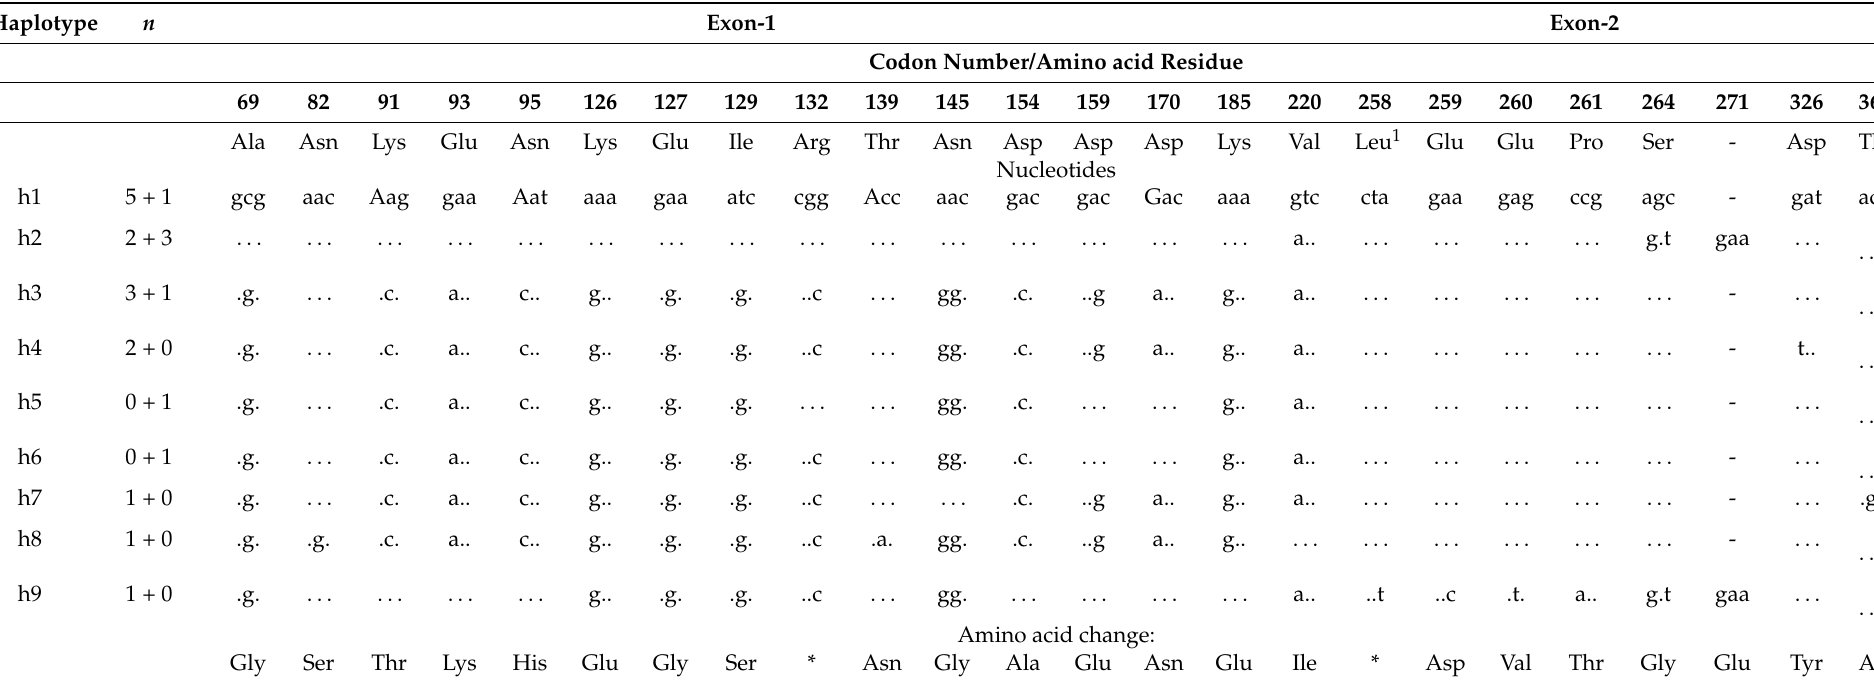
All seven sequences obtained in this study had codons ctc ttc tcc ttc at the amino end, similar to the Sal I sequence (X_001615090.1); the codons are numbered to this sequence. * No amino acid variation. N, number of isolates (sequences from PlasmoDB + from this study). (-) Absence of codon. Codons from 69 to 220 and from 258 to 363 correspond to exon-1 and exon-2, respectively. Note that most frequent haplotypes were present in our study and found in the PlasmoDB repository